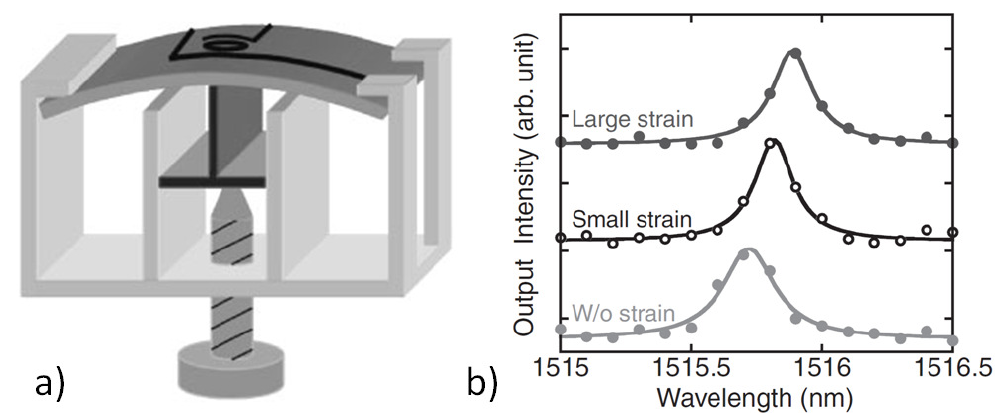
Figure 3. ( a ) Si race track ring resonator on silica bent in a sample holder; ( b ) Resonance characteristics at about 1515.5 nm for horizontal strain. Figure is taken from Reference [15] with courtesy of the Japan Society of Applied Physics.